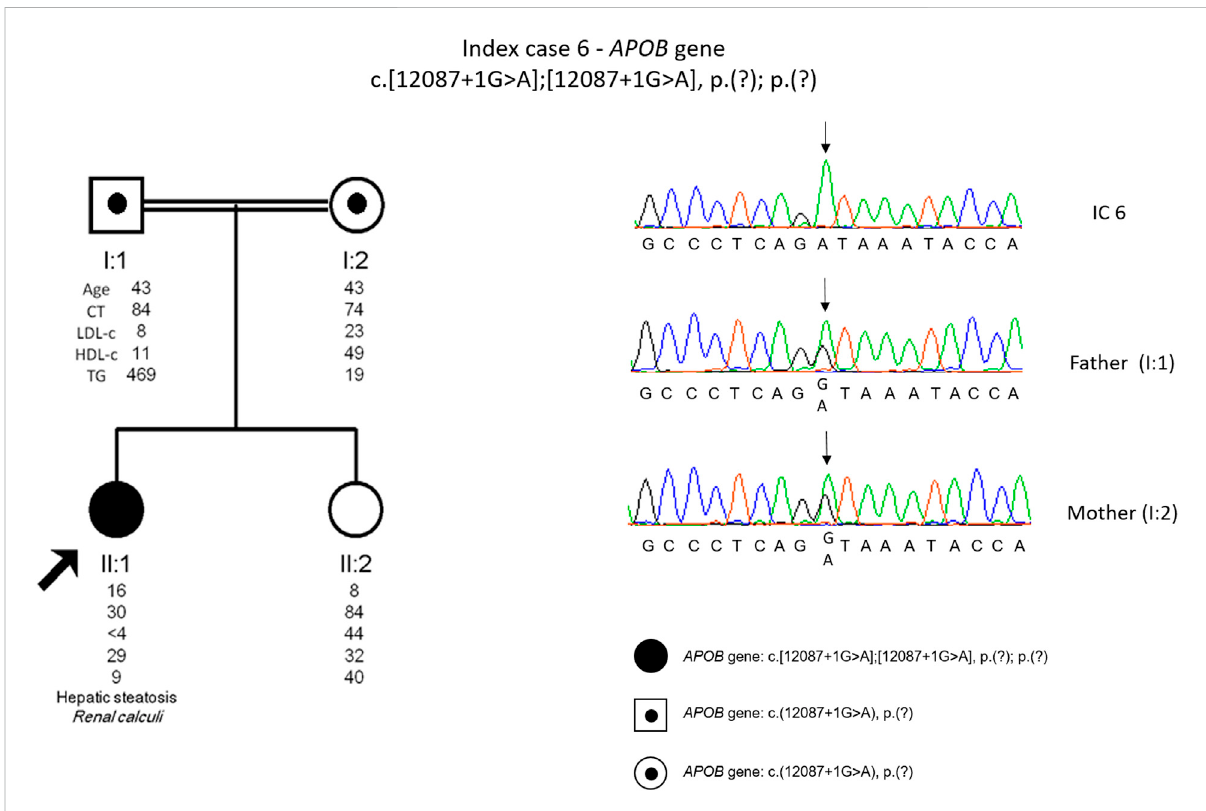
FIGURE 6 Arrow indicates indexcase 6 (IC6). Age (in years) and lipid pro fi le inmg/dLare under each symbol. Black point symbol represents heterozygous individual for the variant in APOB gene, c.12087+1G > A, p.(?); Black symbol represent homozygous individual for the variant in APOB